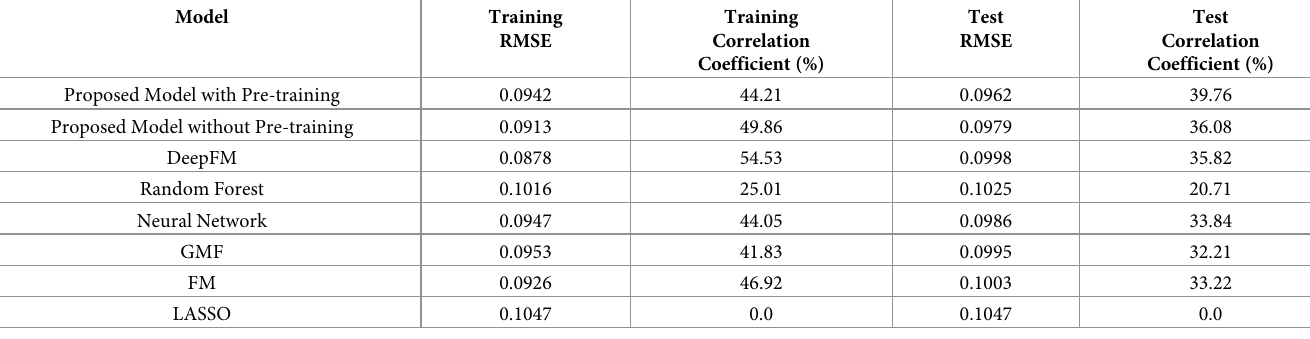
Table 1. Yield prediction performance of the competing models using 10-fold cross validation.